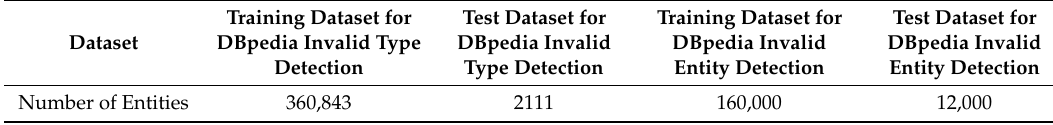
Table 1. Summary of the number of instances in the